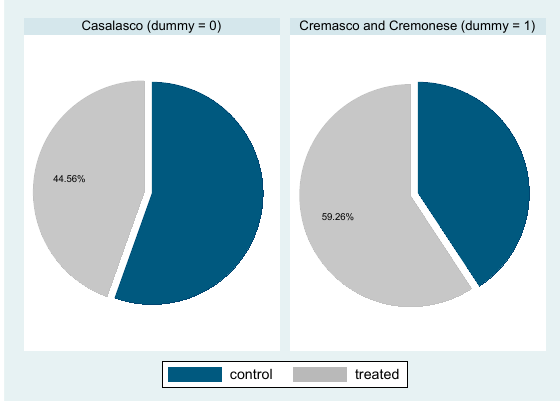
Figure 1. Percentage of localization areas adoption. Source: Our elaborations on survey.